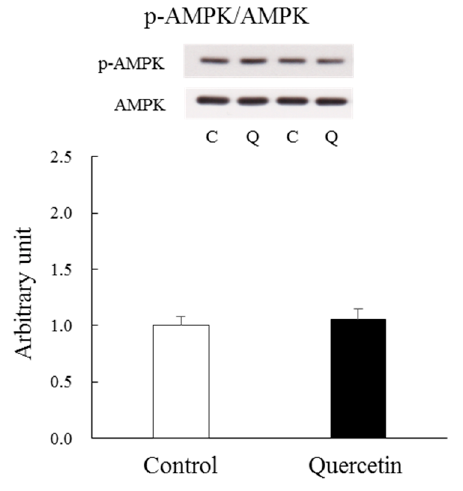
Figure 2. Acute e ff ect of quercetin administration on AMPK phosphorylation. Epitrochlearis muscles were dissected out 6 h after oral quercetin or vehicle (control) administration. A representative blot is shown above figure. The obtained values of p-AMPK were normalized with the value for AMPK. Values are means ± SE ( n = 6). C: control, Q: quercetin.